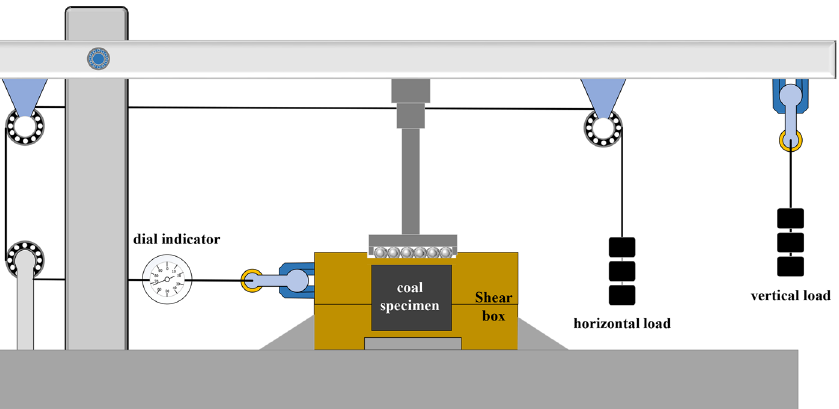
Figure 2. Soft rock shear creep testing machine for the lever gravity